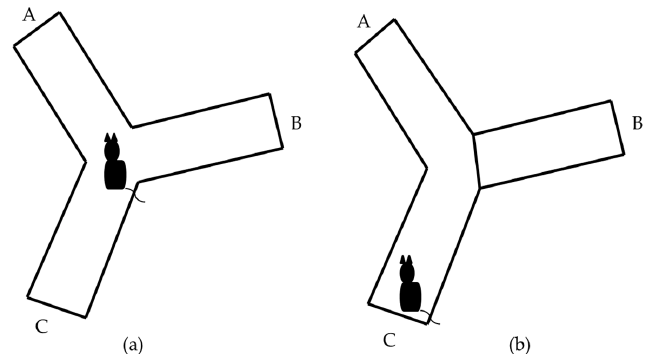
Figure 1. Schematic representation of Y-maze task. The letters A, B and C identify each arm. ( a ) Represents the task with the three open arms; ( b ) Represents the task with one arm blocked.